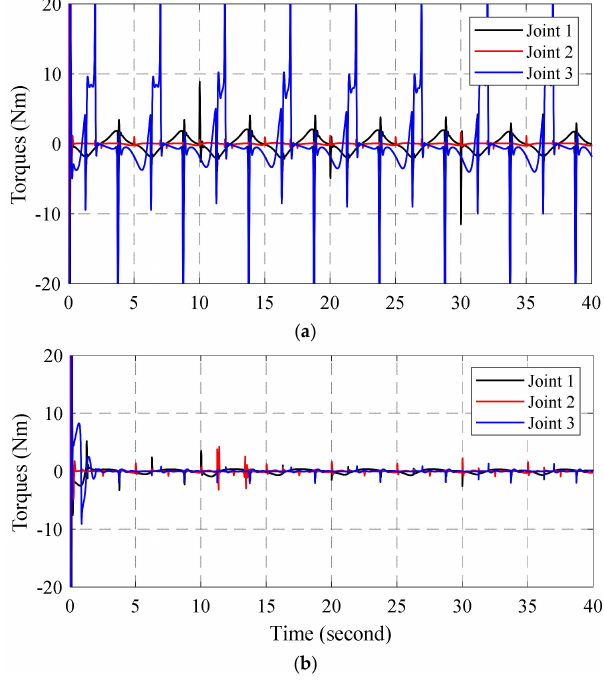
Figure 7. Torque errors with ( a ) BSMC, and ( b ) ABSMC.